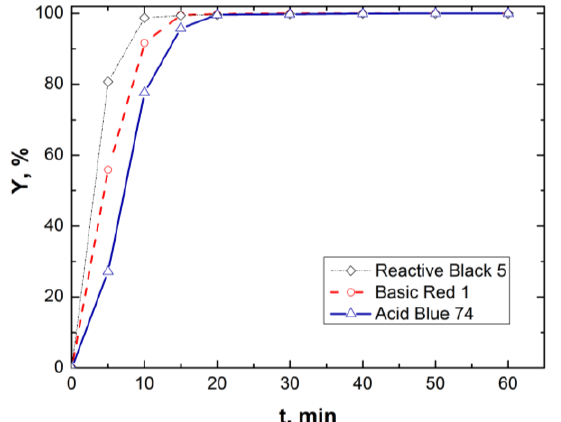
Figure 3. Removal of different dyes by EC ( C C = 26 mM, DC NaCl